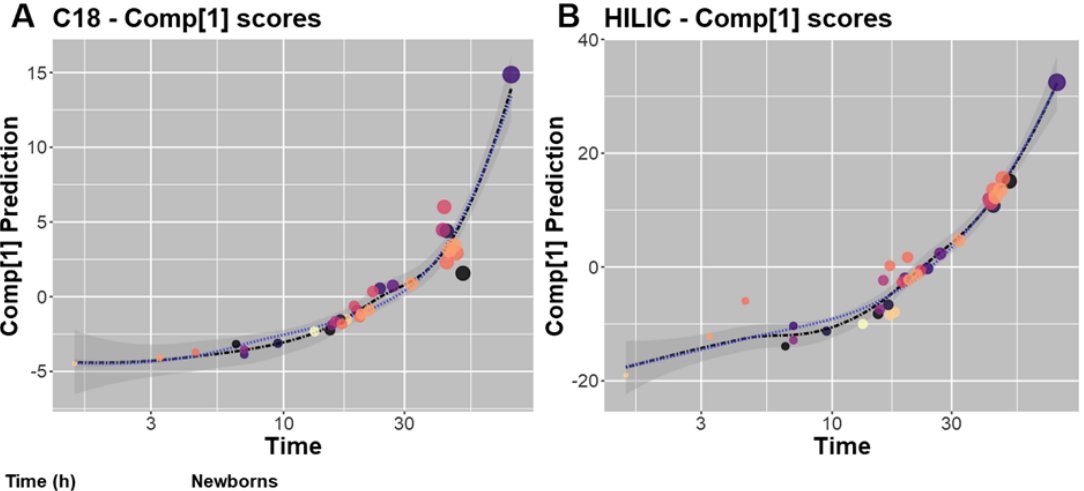
Figure 6. Curvilinear regressions modeled with polynomials of degrees 4 and 3 for the prediction of Comp[1] scores upon log(time) for metabolites analyzed under C18-ESI + ( A ) and HILIC-ESI − ( B ) conditions, respectively. As dashed black lines, the loess-supported regressions are shown with a confidence interval of 5% shown in dark grey, and the dotted blue lines display the polynomial regressions.